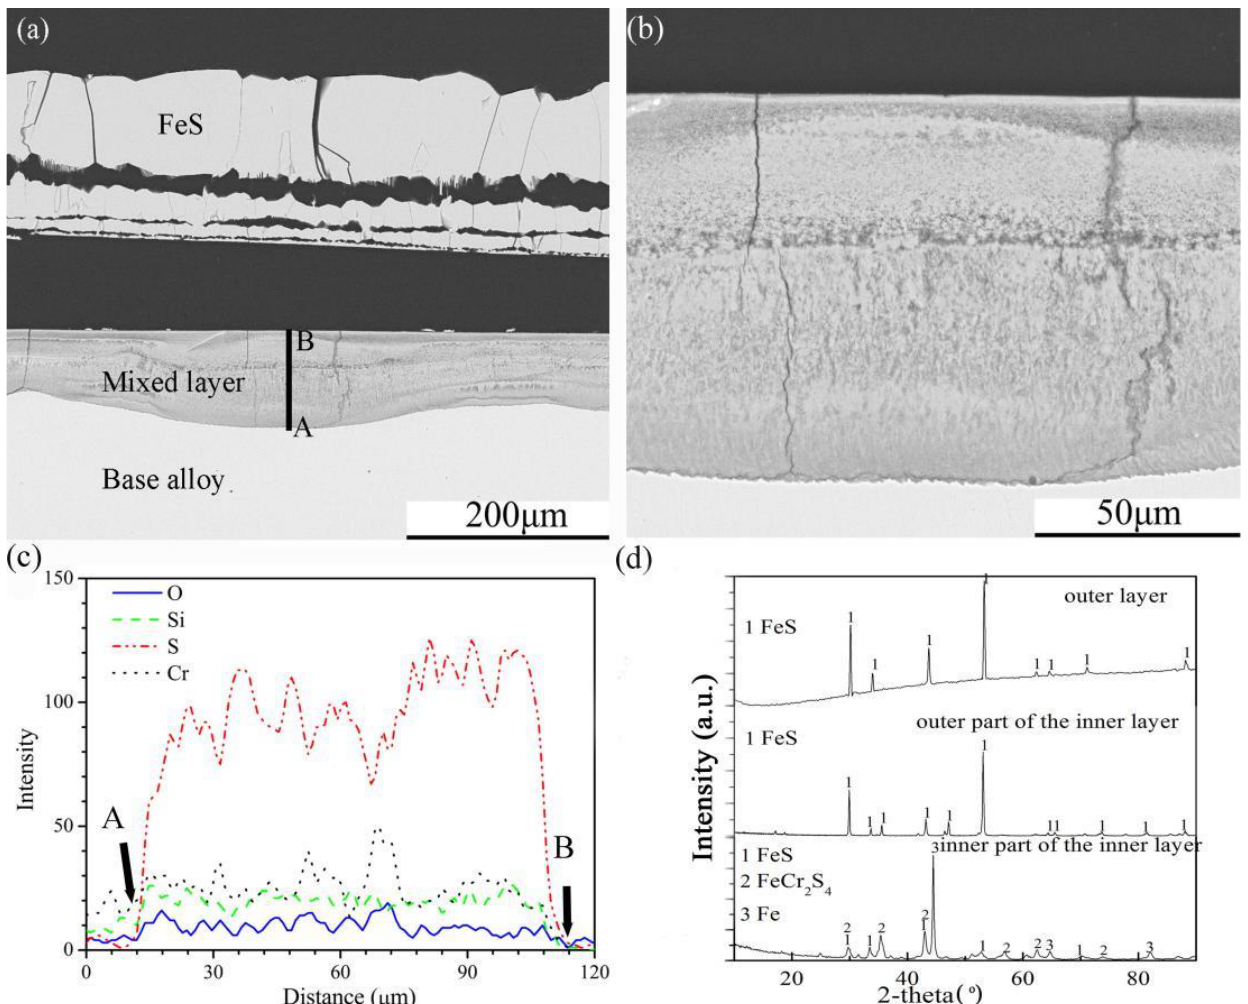
silicon and chromium oxide particles. The XRD patterns of the whole scales are shown in Figure 6d. Pure FeS made up the outermost layer of the multilayer structure. The outer part of the internal layer was composed of pure FeS, and FeCr 2 S 4 was formed in the inner part of the internal layer.